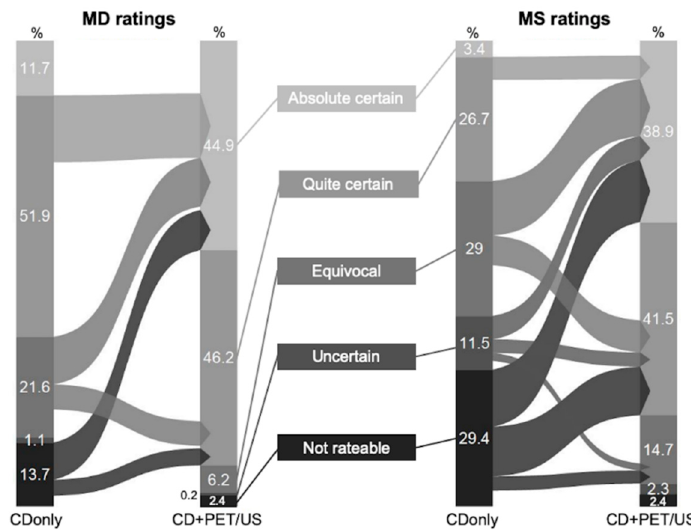
Figure 2. Illustration of the relative rating shifts in the observers’ confidence in functional assessment of thyroid nodules (TN) between conventional diagnostics (CDonly) and CD + I-124-PET / US fusion imaging (CD+PET/US). The left part of the graphic represents the ratings of the nuclear medicine physicians (medical doctors, MD) and the right part the ratings of the medical students (MS).